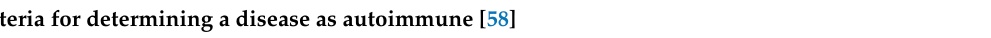
Table 3. Criteria for determining